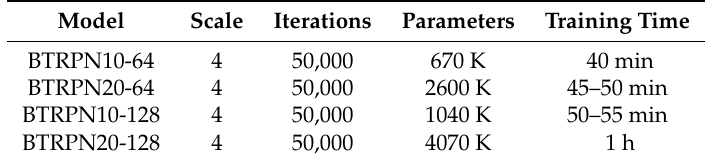
Table 3. Time consumption of different BTRPN models for 50,000 iterations.